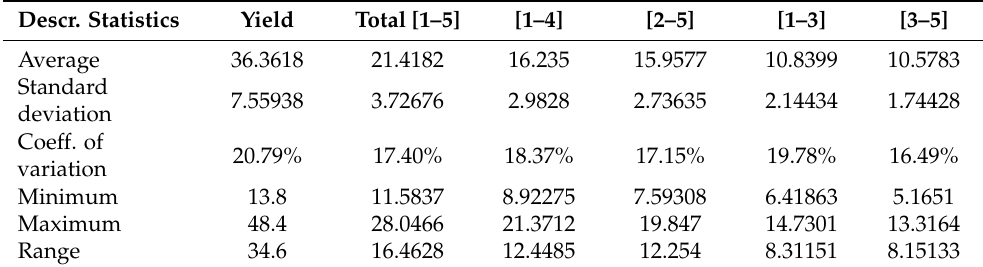
Table 3. The descriptive statistics of the recorded yield data and mean NDVI cumulative values across all cumulative ranges and pilot